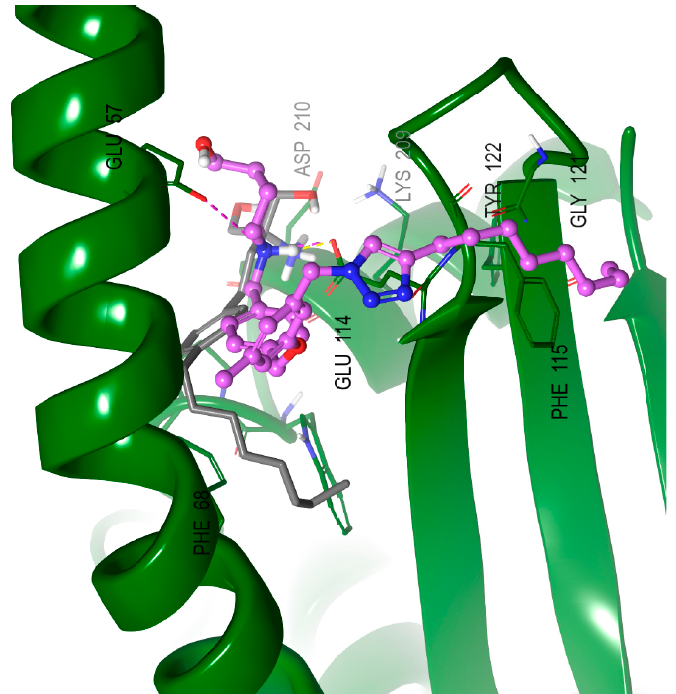
Figure 6. Docking model of FTY720 (gray, thick tube) and compound 10 (pink, ball and stick) in the I2PP2A/SET. The X-ray structure of IPP2A/SET was obtained from the Protein Data Bank (PDB code 2E50). The I2PP2A/SET is represented by a blue ribbon model. The hydrogen bonds are shown as a yellow dashed line, and a pink dashed line represents salt bridge